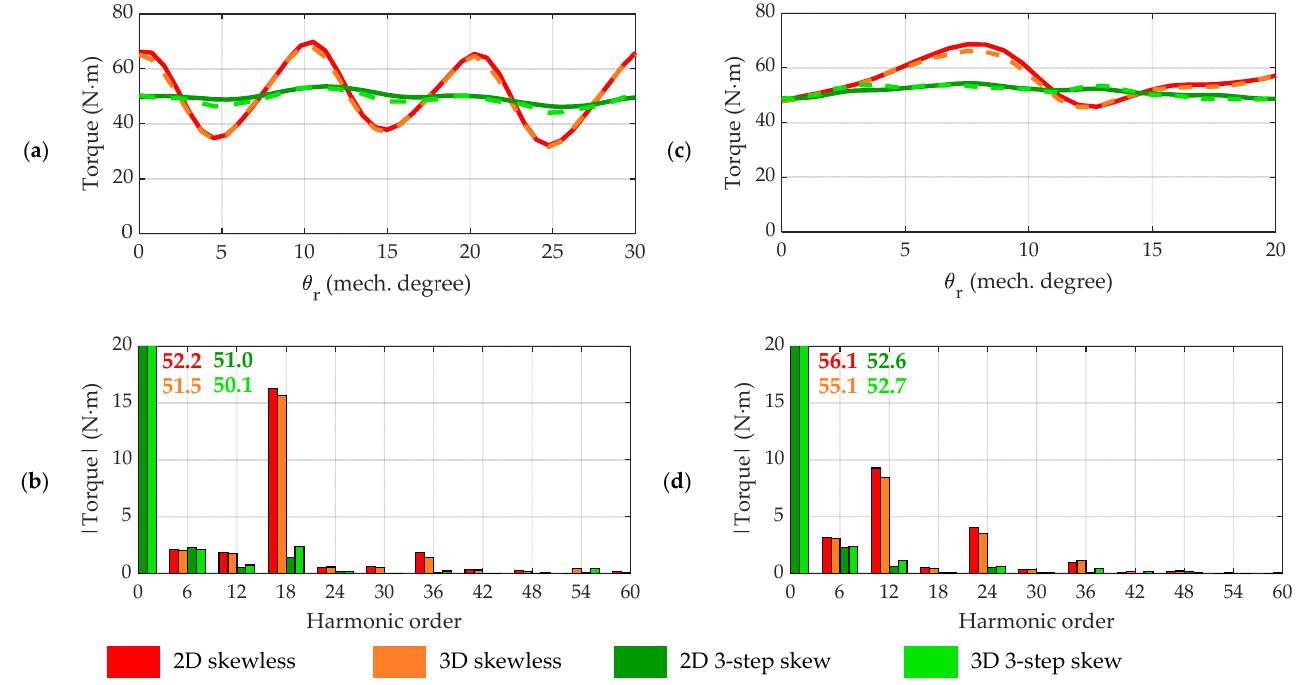
Figure 8. Comparison of electromagnetic torque waveform and harmonic content of skewless ma- chine vs. four-step skewed machine: ( a ) torque waveform of four-pole machine with two barriers per pole; ( b ) torque spatial harmonic content of four-pole machine with two barriers per pole; ( c ) torque waveform of six-pole machine with two barriers per pole; ( d ) torque spatial harmonic content of six-pole machine with two barriers per pole. The 2D and 3D simulation results are